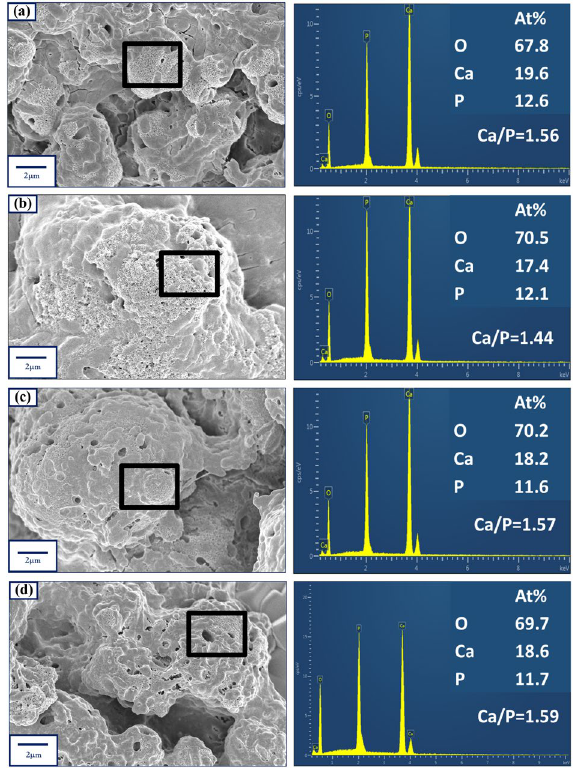
Figure 4. The FESEM micrographs showing clearly the nucleation of dense bone-like apatite structures along with micron-sized pores on the surface of ( a ) HAP, ( b ) BST, ( c ) 80H–20B and ( d ) 20H–80B. The corresponding EDX of the bone-like apatite is also shown which is highest for 20H–80B, implying that the synergistic effect of the Sr, Ba, Ti, PO 3 − 4 and Ca, enhances the biomineralization ability in the composite. The rectangles in ( a ), shows the position from which the EDX signals have been